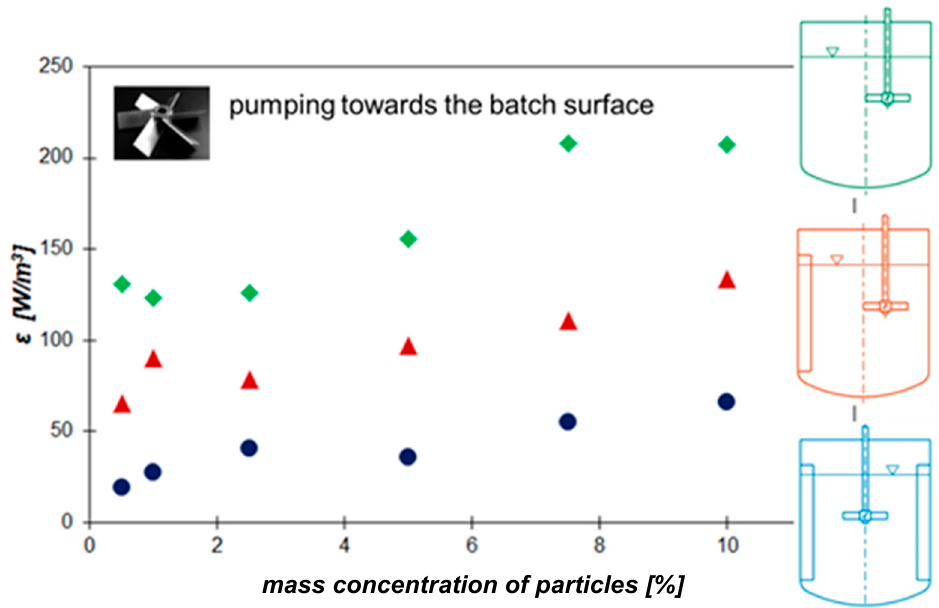
Figure 15. Comparison of power required for the drawing down and homogenization of particles floating on the liquid surface for the most energy efficient configurations of the mixing equipment [36].